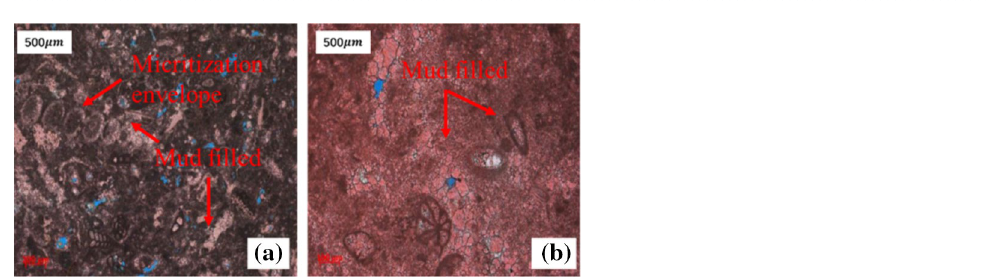
Figure 7. Predicting results of well W-11 based on Bayesian discriminant model.